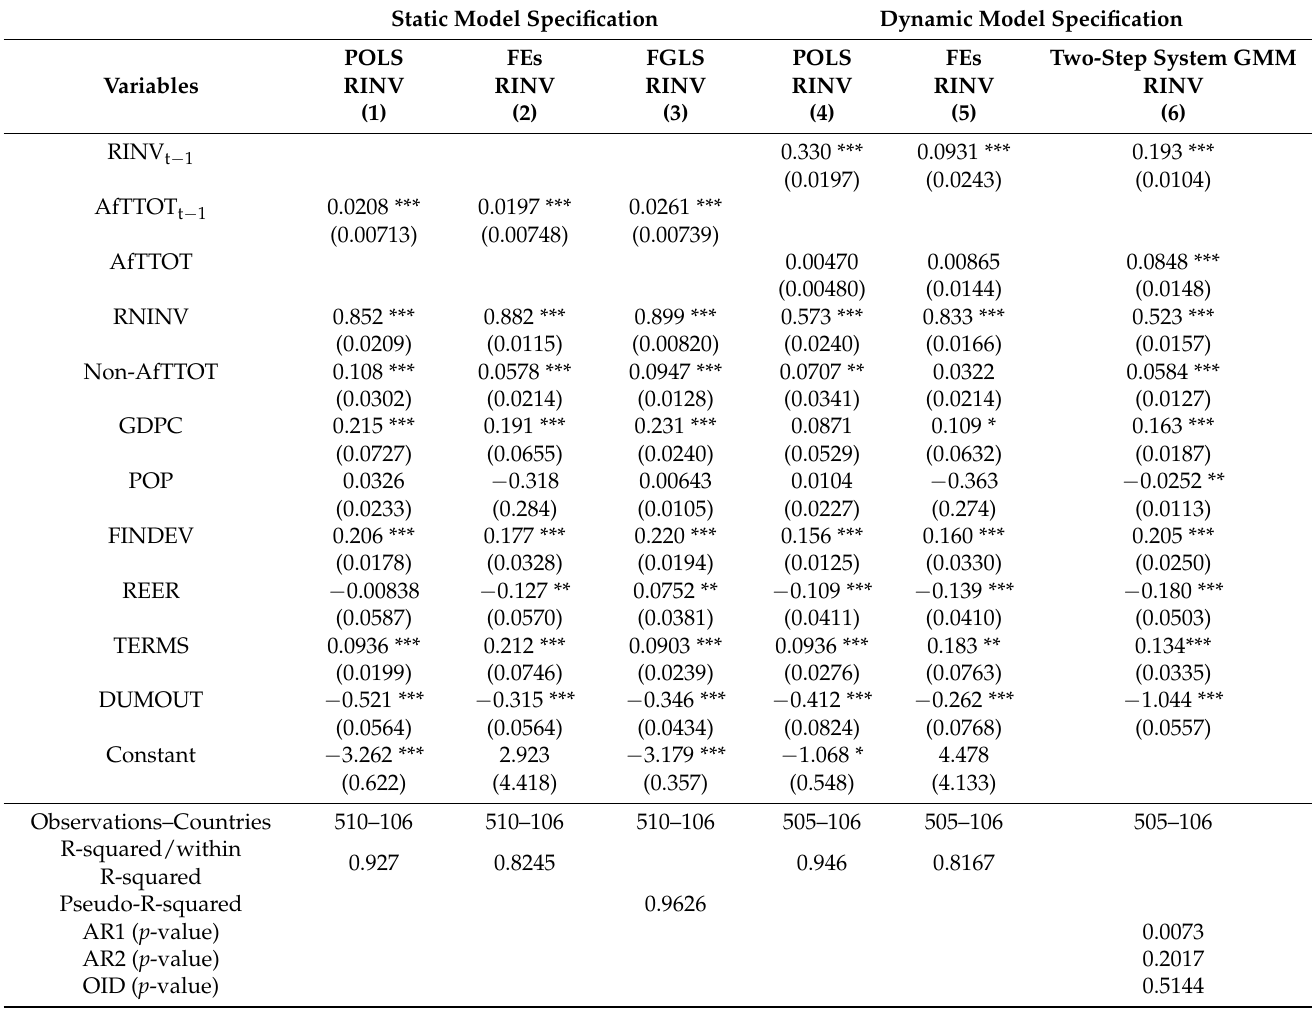
Table 1. Effect of total AfT flows on investment-oriented remittance flows. Estimators: POLS, FEs, FGLS and two-step system